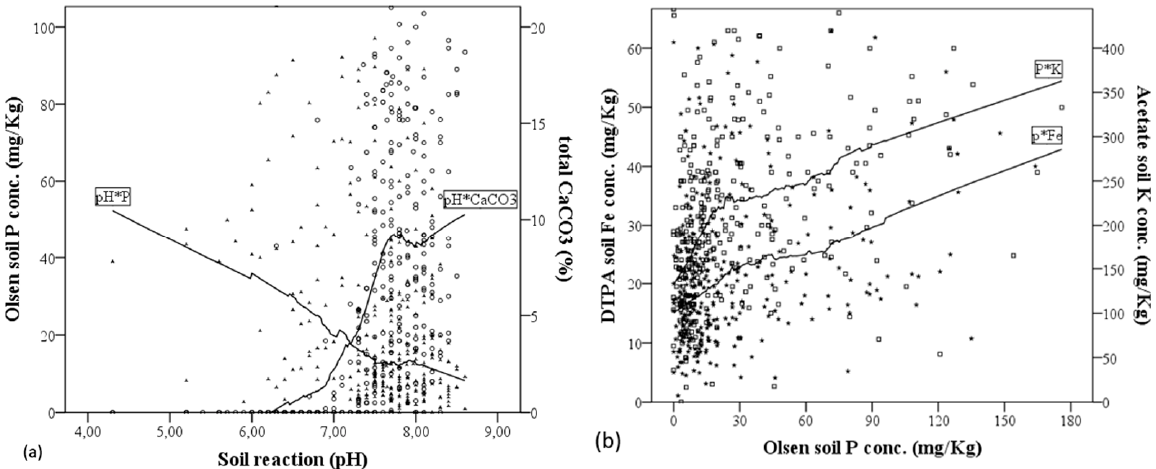
Figure 2. ( a ) Effect of soil pH and total CaCO 3 % content in Olsen P concentrations ( ˆ ). ( b ) Correlation of K ( □ ) and Fe (*) soil concentrations with Olsen P.